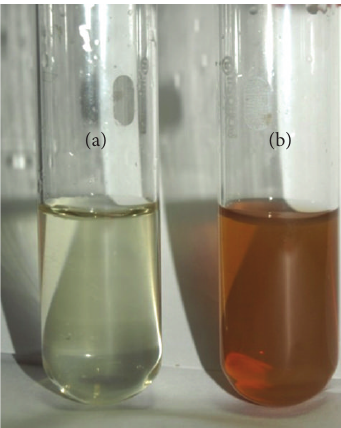
F 2: Reductase assay for qualitative evaluation of reducing entities in Tulsi extract (colour change from yellow to brick red acts as an indicator of strong reducing potential of Tulsi +